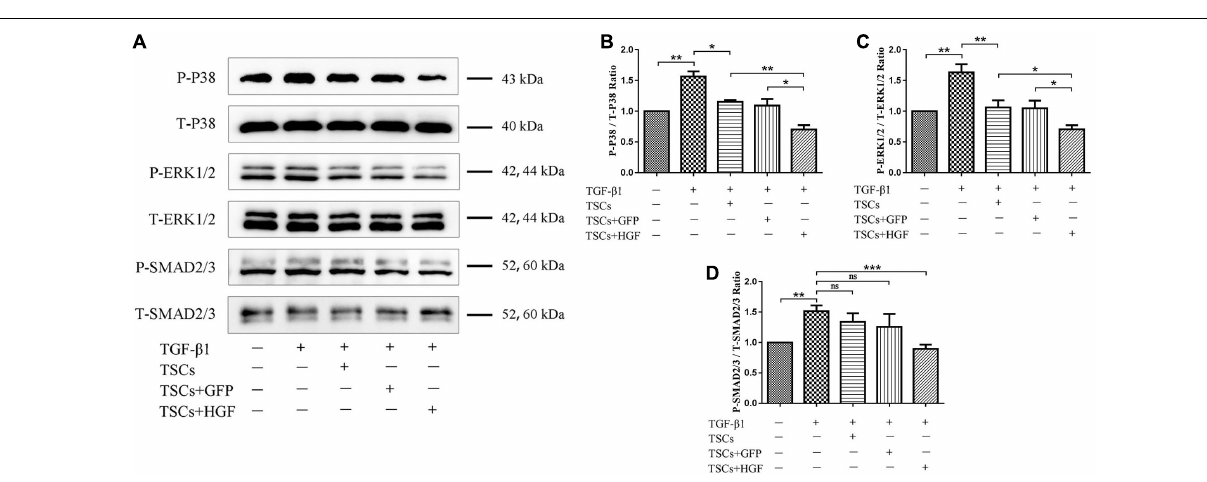
FIGURE 8 | Effect of coculture with TSCs on tendon fibroblast TGF- β 1-induced signaling pathways. (A) Western blots demonstrating p38 MAPK, ERK1/2, and Smad2/3 protein levels. Quantitation of (B) phospho-p38 MAPK, (C) phospho-ERK1/2, and (D) phospho-Smad2/3 proportions ( n = 3). Data are represented as mean ± SD. * P < 0.05, ** P < 0.01, *** P <